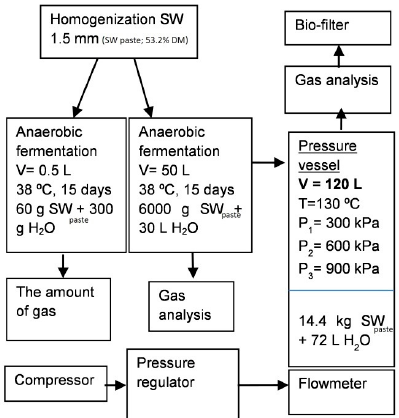
Figure 1. Diagram of the nitrogen removal trial. Homogenized slaughterhouse waste (SW) was first mixed with some water to obtain SW paste which was further diluted with water to get mixture containing ca. 8% DM. Diluted SW was anaerobically hydrolyzed and fermented in pre-trials (0.5 L and 50 L containers), and then in the pilot size 120 L pressure vessel, where ammonia was removed under three di ff erent pressures (300, 600, and 900 kPa), at constant temperature (T = 130 ◦ C), and air flow (144 NL /